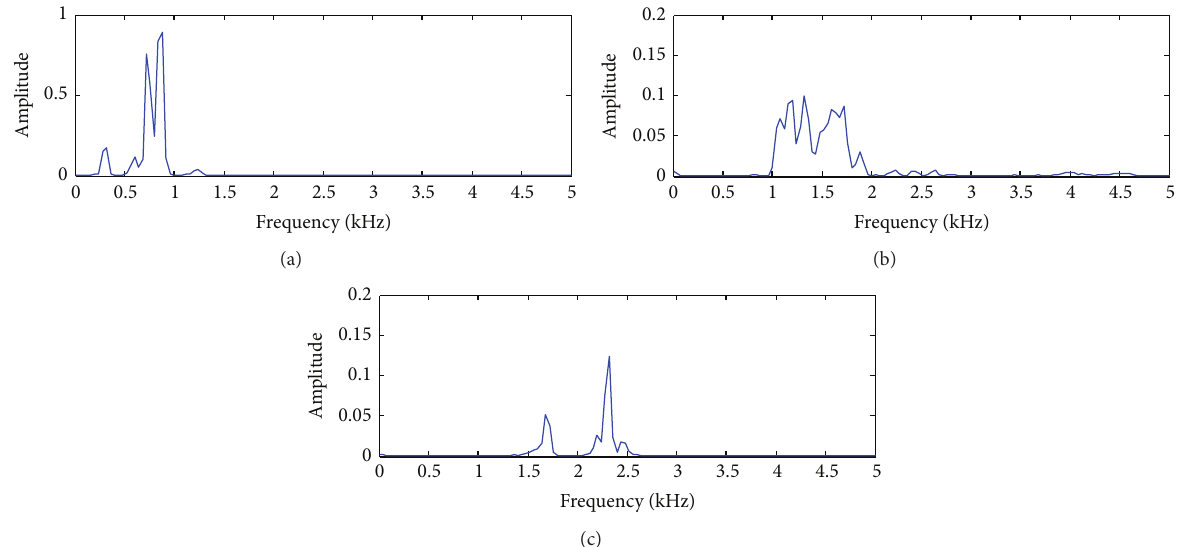
Figure 8: Spectra of signals recorded on different samples. (a–c): (a) sample with serious defect, (b) sample with early defect, and (c) sound